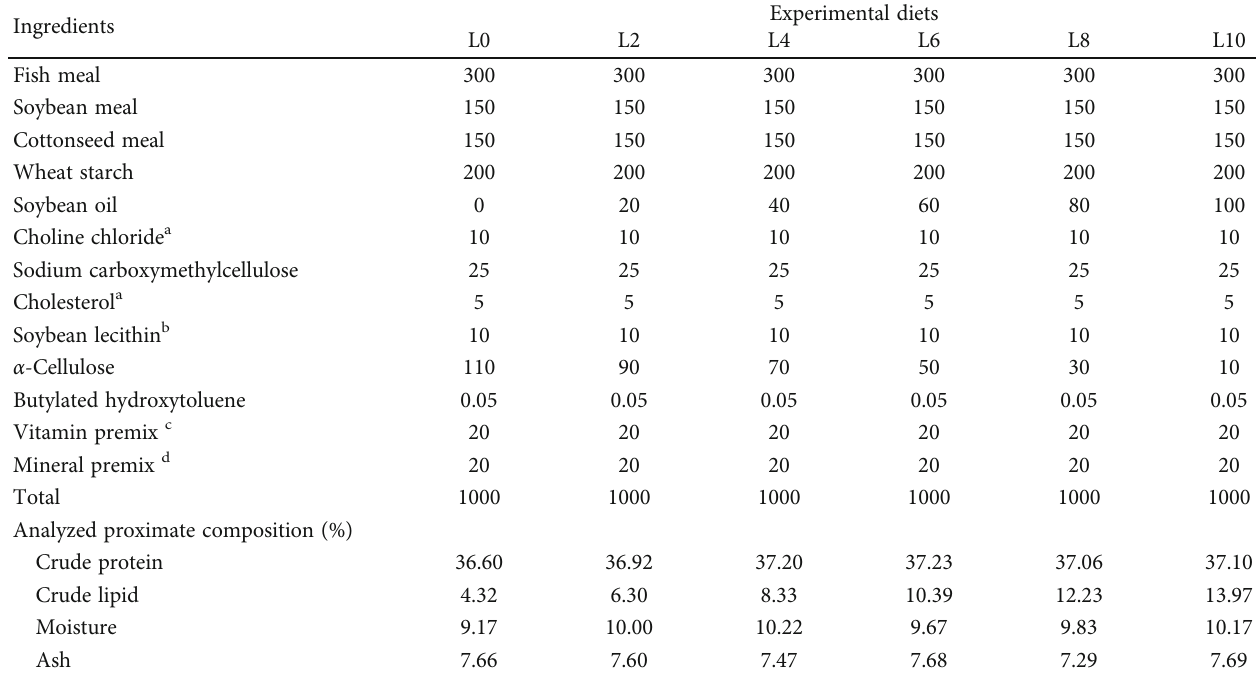
Table 1: Ingredient formulation (g/kg dry matter) and proximate composition (%) of the six experimental diets for juvenile C. quadricarinatus